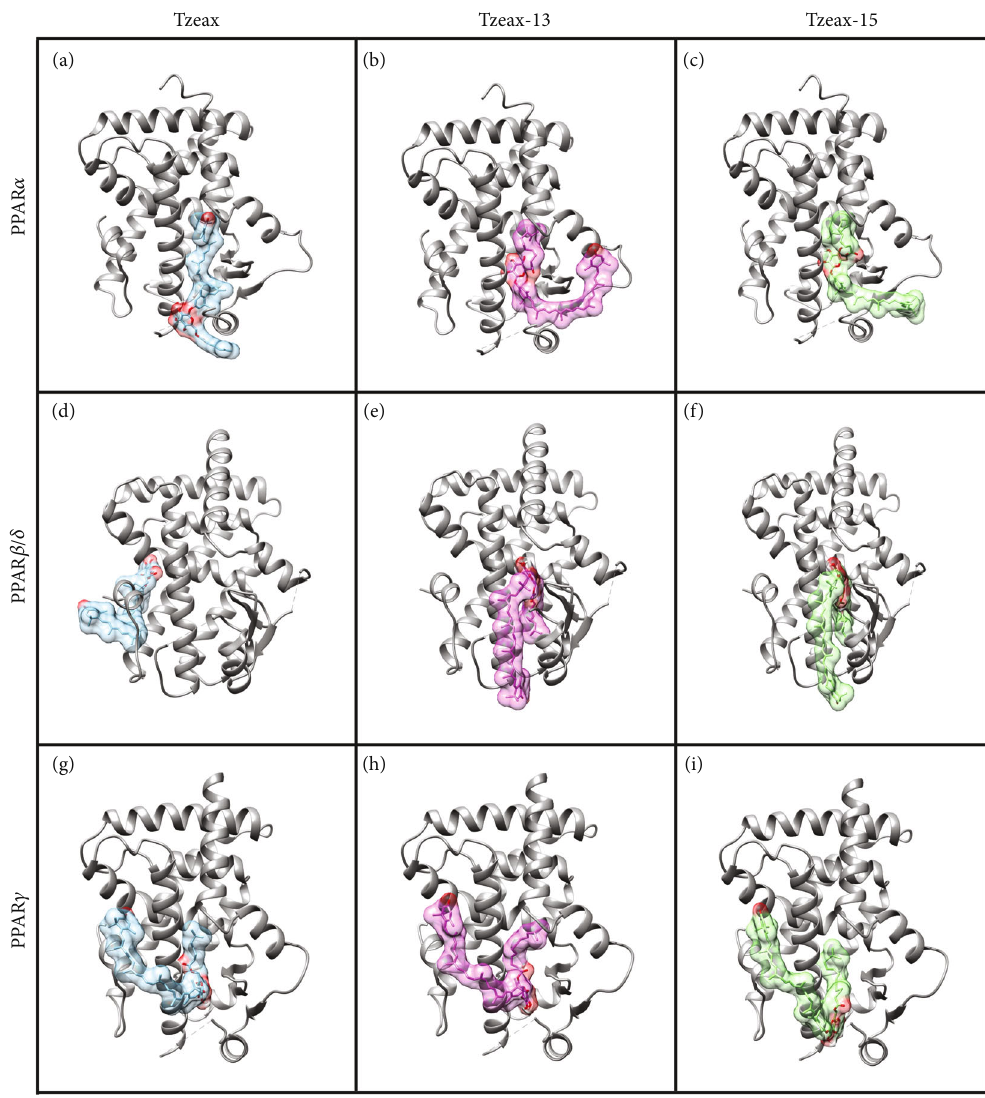
Figure 9: Ribbon diagrams of PPAR α , PPAR β / δ , and PPAR γ (grey) bound to surface/ribbon diagrams of (a, d, and g) Tzeax (blue), (b, e, and h) Tzeax-13 (pink), and (c, f, and i) Tzeax-15